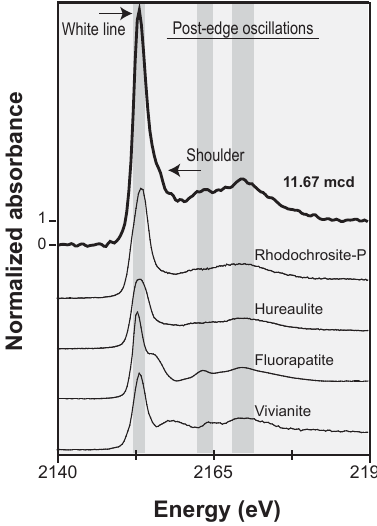
Figure 7. Unfocused P XANES spectra of bulk sediment from 11.67mcd (hole C) and various standards. All standards are de- scribed in Dijkstra et al. (2016). The dark grey shading highlights areas of specific interest. The positions of main features of the bulk sediment spectrum (the white line, post-edge shoulder and the post- edge oscillations) are indicated in the figure. The white line (main absorption step) is observed in all P spectra, whereas the shoulder features are only visible in the bulk sediment spectrum and the flu- orapatite